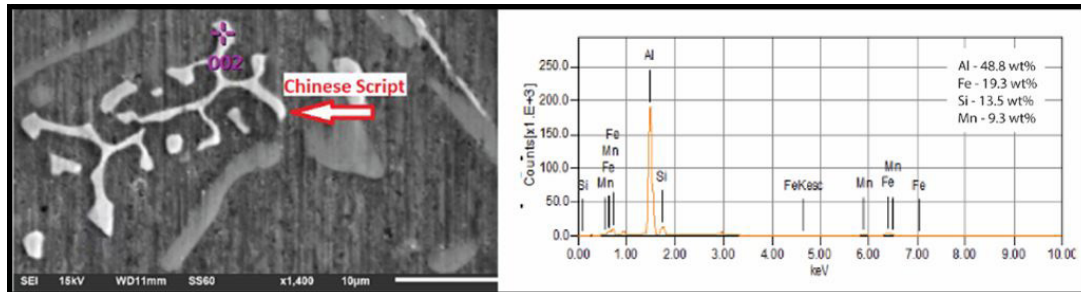
Figure 6. SEM images and EDS spectrum of the microstructure with presence of the intermetallic phase (Chinese script) correspondent the sample submitted at 500 o C followed by ageing at 190 o